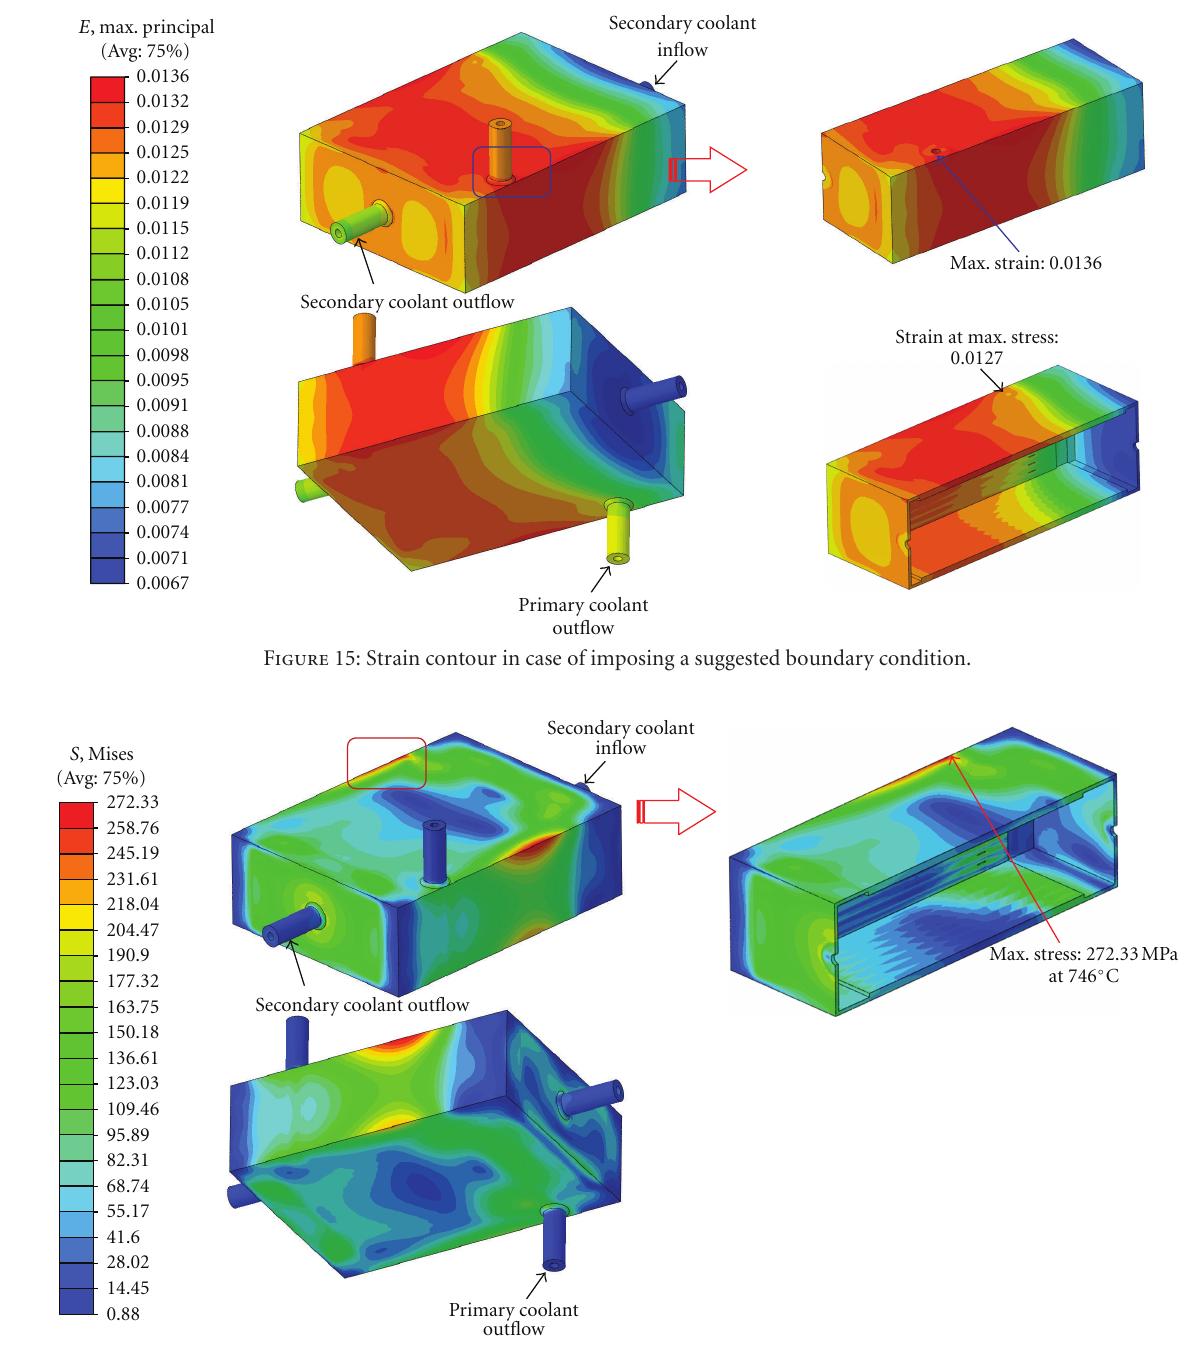
Figure 16: Stress contour in case of imposing a suggested boundary